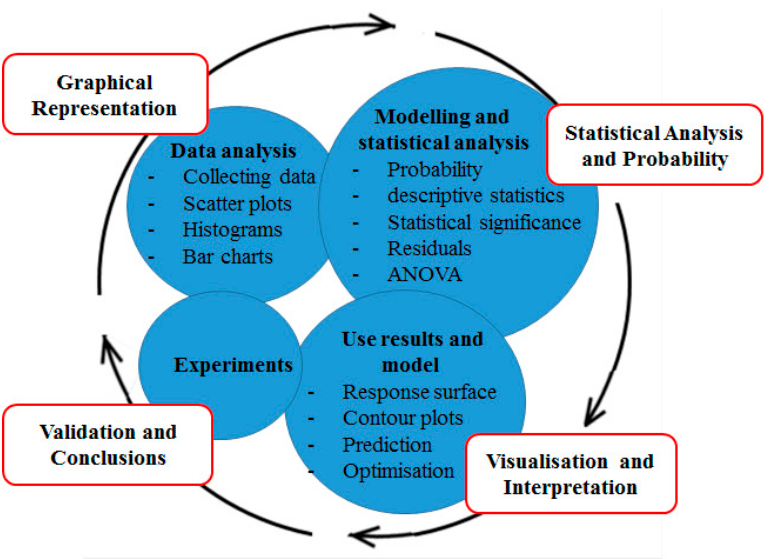
Figure 5. A typical DoE analysis route from initial Experiments to validation and conclusions. The rationale for data analysis is to evaluate the effects of variables on response. Graphical Representation shows how the data are distributed. The Statistical Analysis and Probability stage identifies variables that are statistically significant. This will identify variables that are important to bring forward to the subsequent optimisation step based on their statistical significance. The Visualization and Interpretation stage will focus on representational analysis that identifies optimal levels.